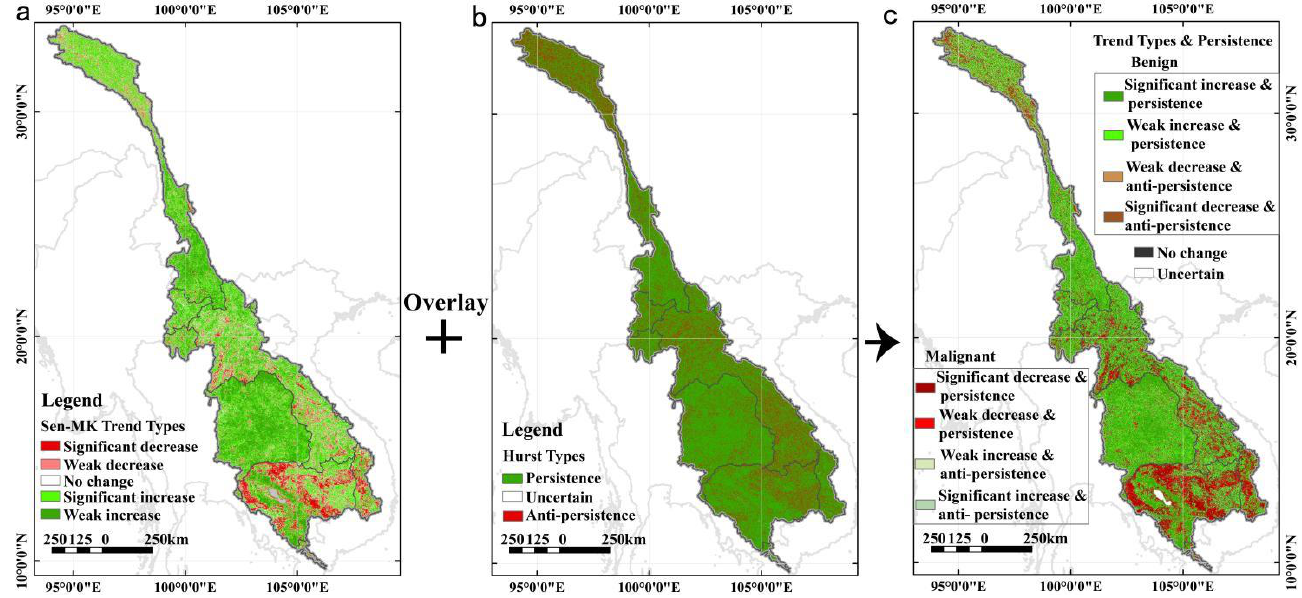
Figure 6. Spatial distribution of NDVI future persistence in the LMRB. ( a ) Sen-MK trend coupling type; ( b ) Hurst sustainability; ( c ) future trend type.